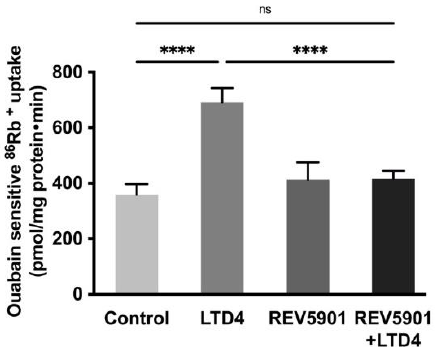
Figure 3. Effect of LTD4 receptor inhibitor REV5901 (5 µ M) on Na-K-ATPase activity in IEC-18 cells